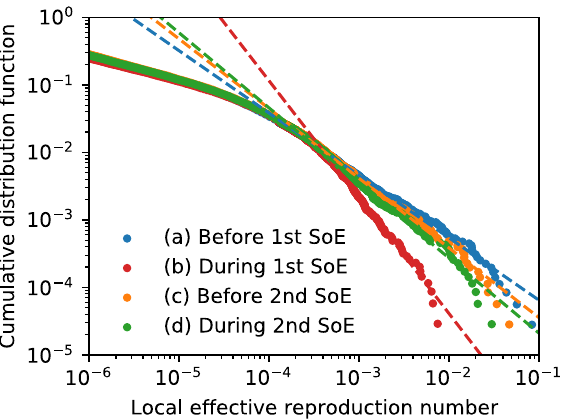
Figure 7. Cumulative distribution function of effective reproduction number at each location on a log–log scale ( a ) 2 months before 1st SoE, ( b ) during 1st SoE, ( c ) 2 months before 2nd SoE, and ( d ) during 2nd SoE. Power-law fitting functions are plotted as dotted lines. The exponents are ( a ) − 0.92, ( b ) − 1.72, ( c ) − 1.03, and ( d ) − 1.11. The sum of the distribution is the total effective reproduction number.